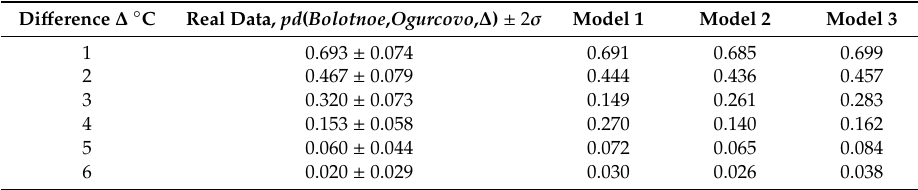
Table 5. Probability pd ( Bolotnoe , ogurcovo , ∆ ) , Area 1, 15